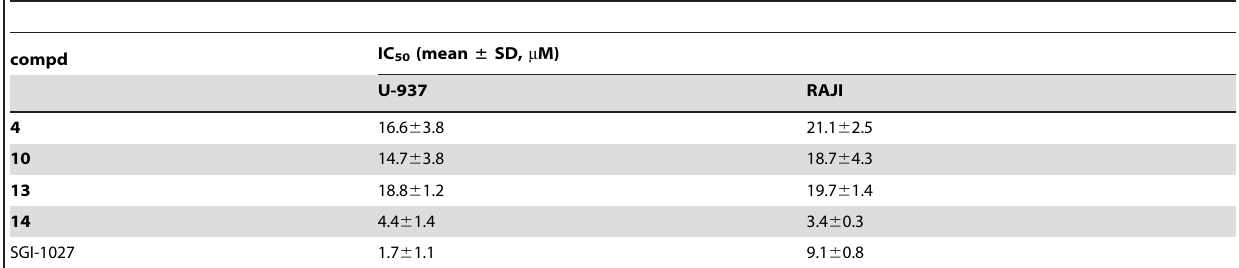
Table 2. Effect of selected quinazoline analogues 4 , 10 , 13 and 14 on human lymphoma U-937 and RAJI cell viability at 48 h*.